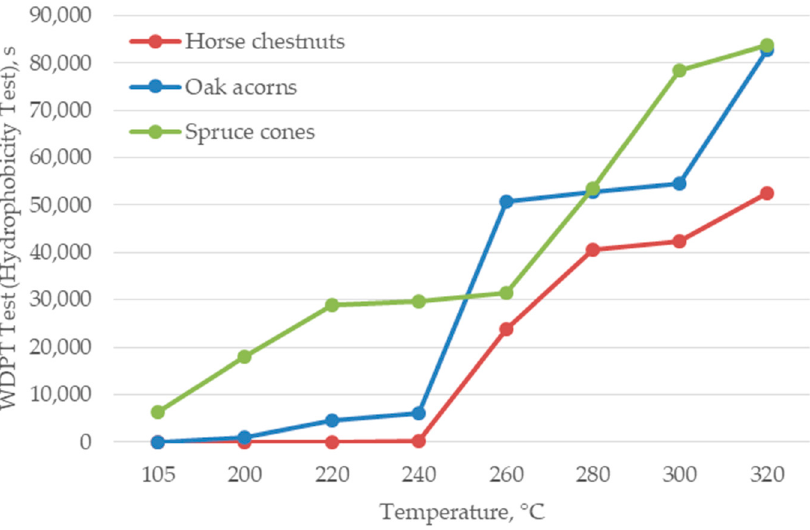
Figure 11. Hydrophobic properties of the raw and torrefied forestry biomass.